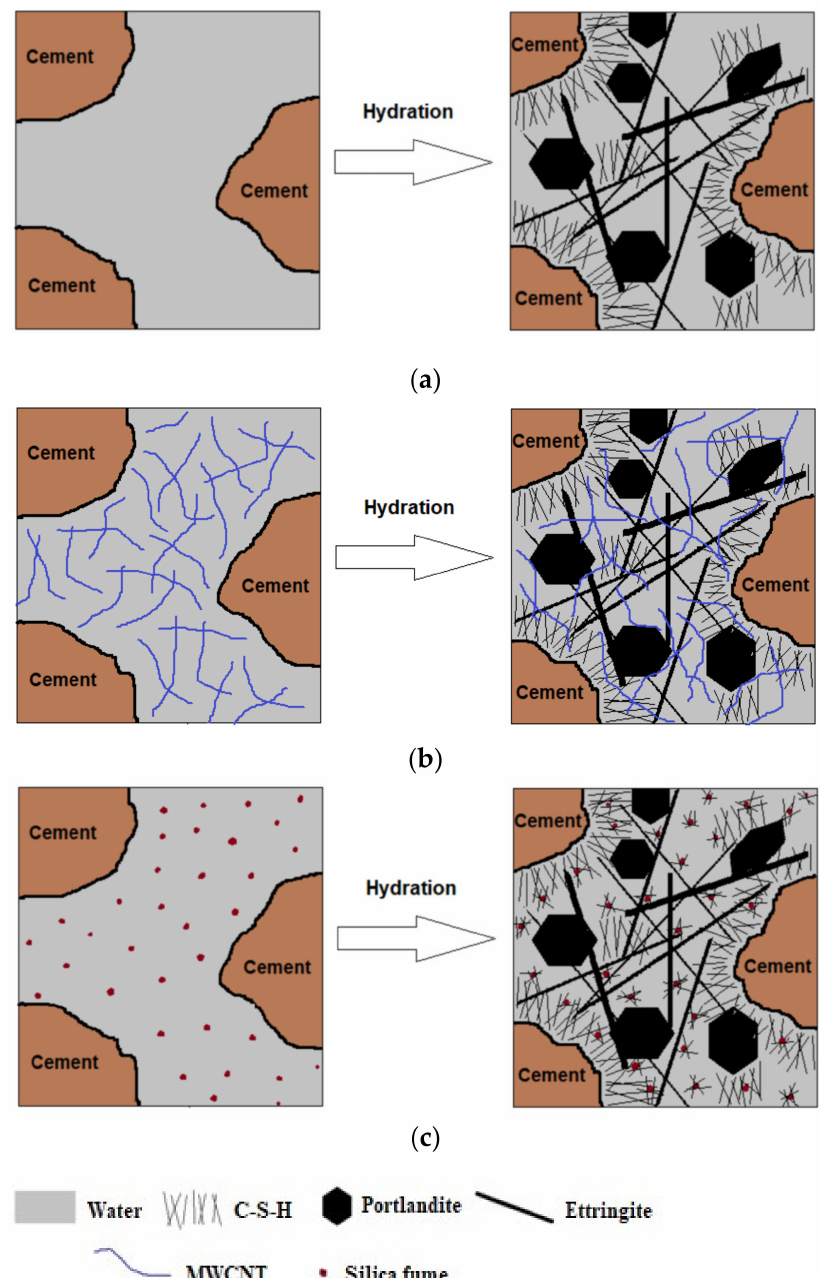
Figure 15. Scheme of the cement paste before and after hydration: ( a ) without additives; ( b ) with multi-walled carbon nanotubes (MWCNTs); ( c ) with silica